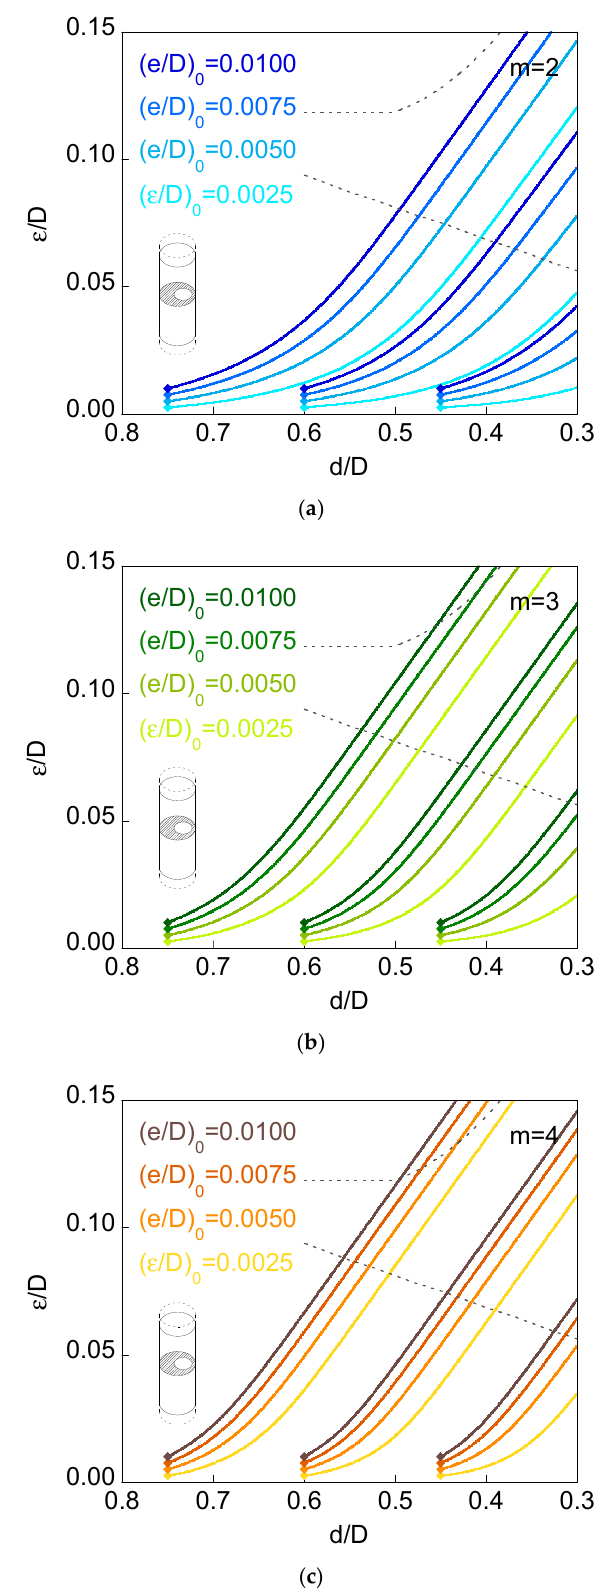
Figure 6. Curves ε / D vs. d / D , fatigue propagation for imposed axial displacement : ( a ) m = 2; ( b ) m = 3; ( c ) m = 4.